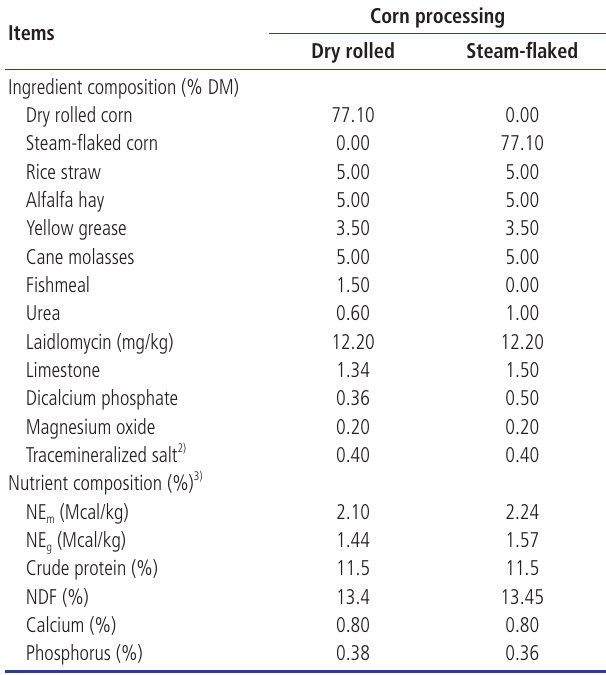
Table 1. Composition of experimental diets (DM basis) 1)